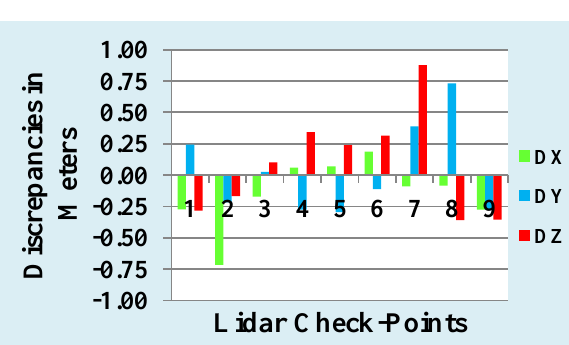
Figure 7. Shows a graphic of tridimensional discrepancies of the LCPs from the 3D photogrammetric intersection using refined IOP and